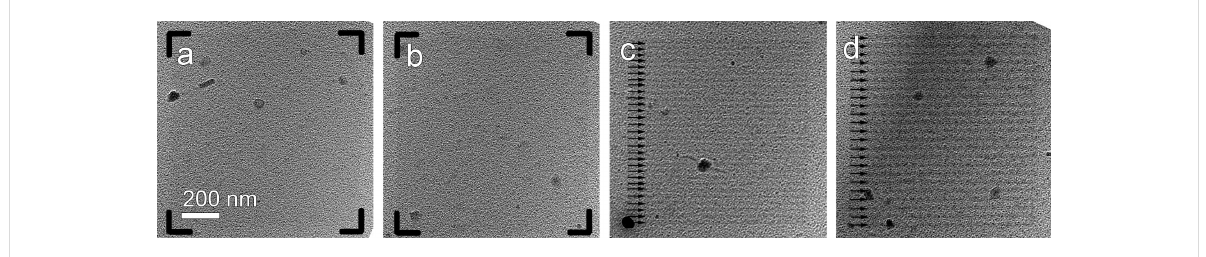
Figure 4: FEBID Pt on amorphous carbon at different defoci of the electron beam. (a) in focus, (b) at 4 μ m defocus, (c) at 8 μ m defocus and (d) at 10 μ m defocus of the 30 kV 0.2 nA electron beam. Stripes with high densities are indicated by arrows and illustrations.